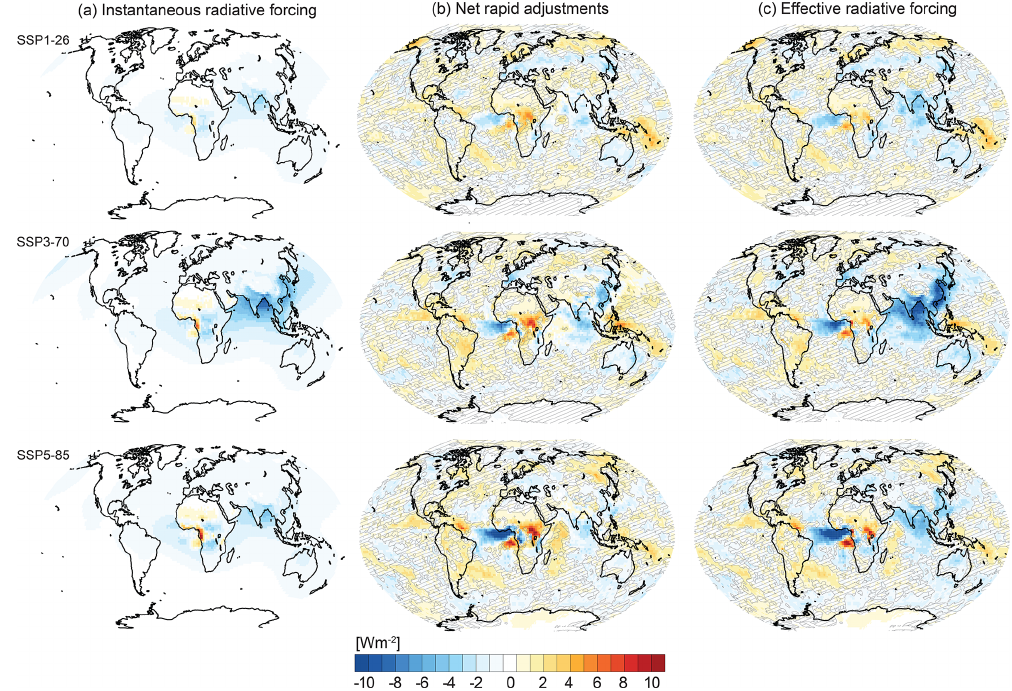
Figure 8. All-sky radiative forcing for the mid-2090s. Shown are the SW TOA (a) RF, (b) the net contribution from rapid adjustments, and (c) ERF for all-sky conditions in the mid-2090s from the CMIP6 emission scenarios. ERFs not significantly different from zero are masked out by hatching, adopting a confidence level of